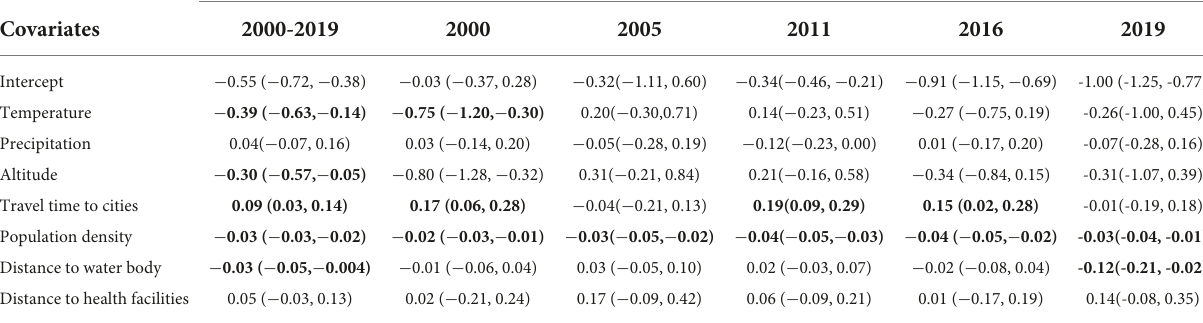
TABLE 2 Regression coefficient mean and 95% credible intervals (CrI) of covariates included in a Bayesian spatial model with Binomial response for the prevalence of underweight in Ethiopia between 2000 and 2019. Mean regression coefficient with 95% credible interval for each